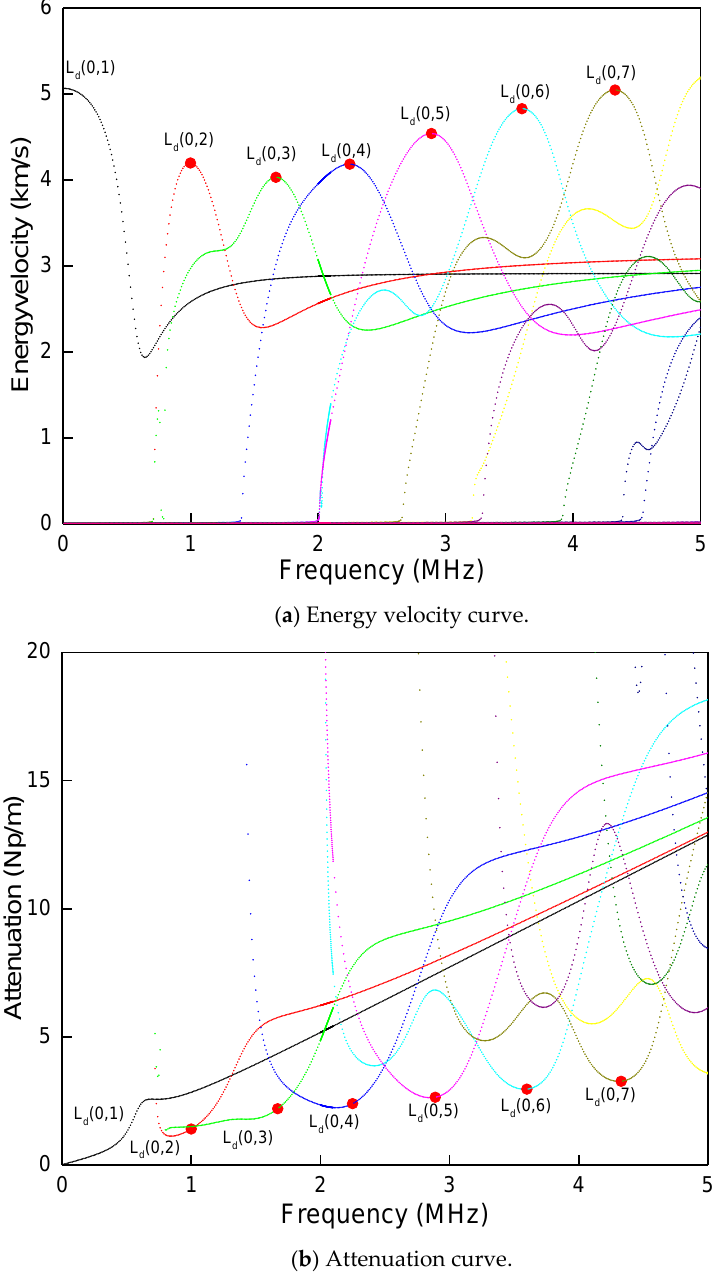
Figure 18. Longitudinal mode dispersion curve for the damped waveguide: ( a ) Energy velocity curve; ( b ) Attenuation curve.